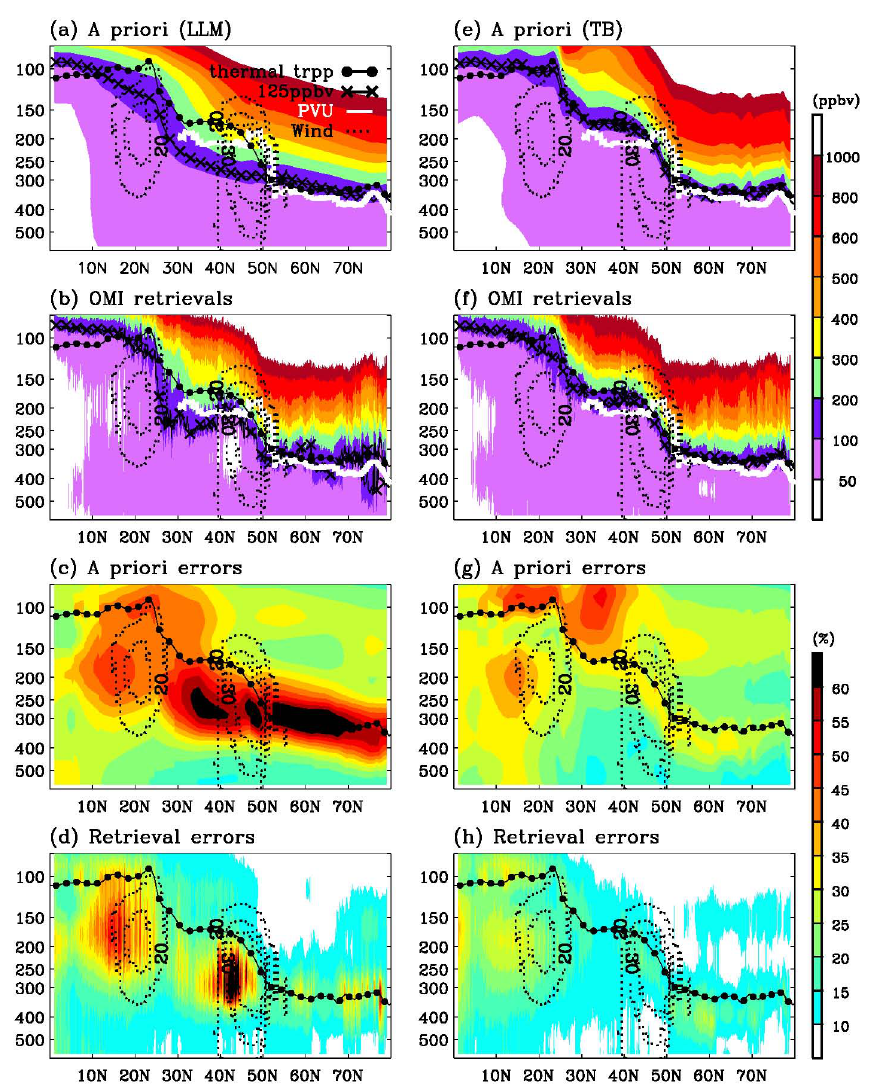
Fig. 6. Profiles of (a) a priori, (b) retrievals, (c) a priori errors, and (d) retrieval errors for 600 to 80hPa along the OMI overpass (solid black line) displayed in Fig. 4d. The LLM and TB climatologies are used to derive the left and right columns, respectively. This overpass is taken at the nadir position, at which the satellite viewing zenith angle is less than 4 ◦ , with the overpass time of 15:24UTC near the equator. The a priori/retrieval errors are normalized to their a priori/retrievals (%). The black dotted lines denote the wind speed of 20, 30 and 40ms − 1 . The 125ppbv value of ozone (black line with Xs), 2 PVU value (white line), and thermal tropopause (trpp) height (black line with circles) are